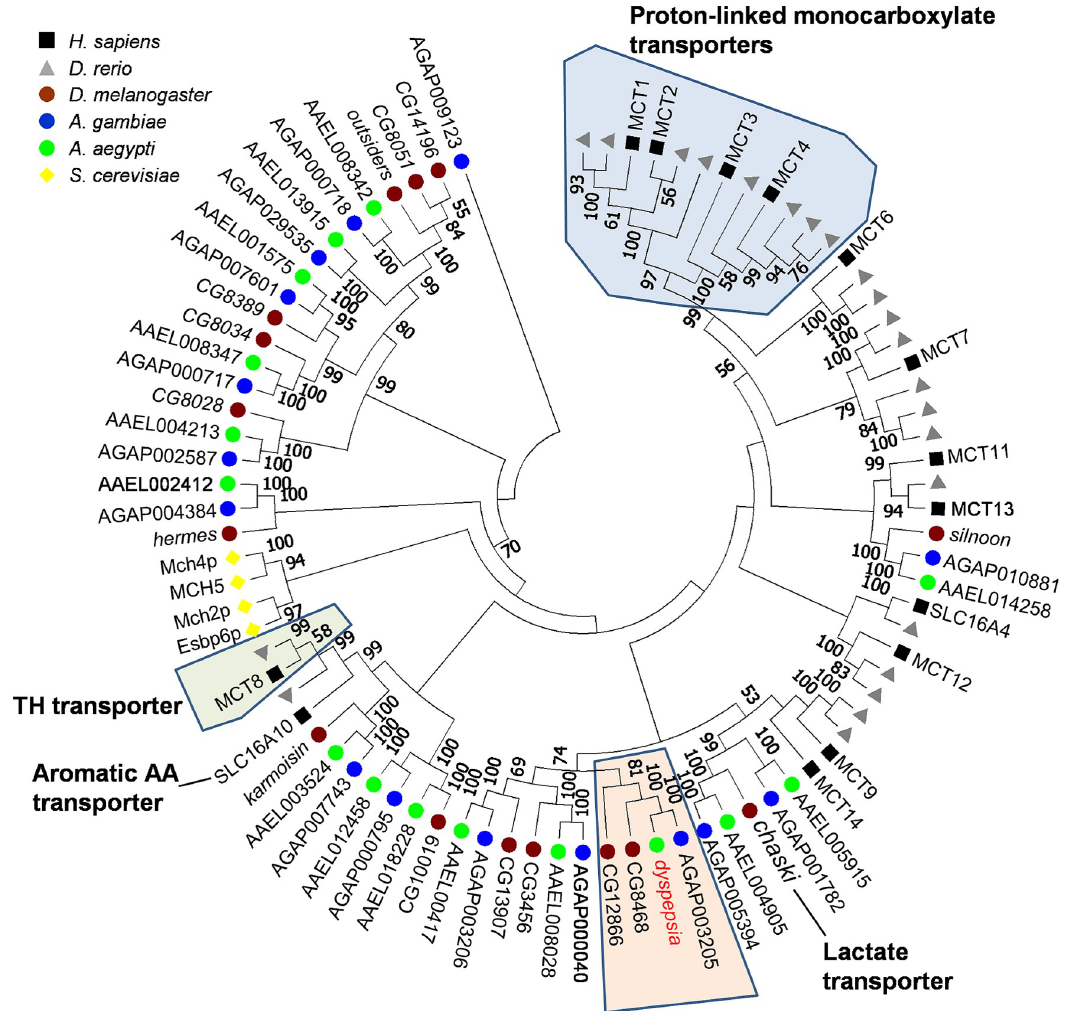
Fig 8. Phylogenetic analysis of SLC16 proteins between vertebrates, dipterans and yeast. Predicted amino acid sequences of 86 SLC16 members were aligned using Muscle as implemented in MEGA7 under the default parameters. The resulting alignment was used to generate a tree using the Neighbor-joining method, with the pairwise deletion option and bootstrapping (n = 1000). The bootstrap consensus tree is displayed, with percent bootstrap support indicated on each node when greater than 50%. SLC16 members with known substrates are indicated; dipteran-specific clade containing dysp is highlighted